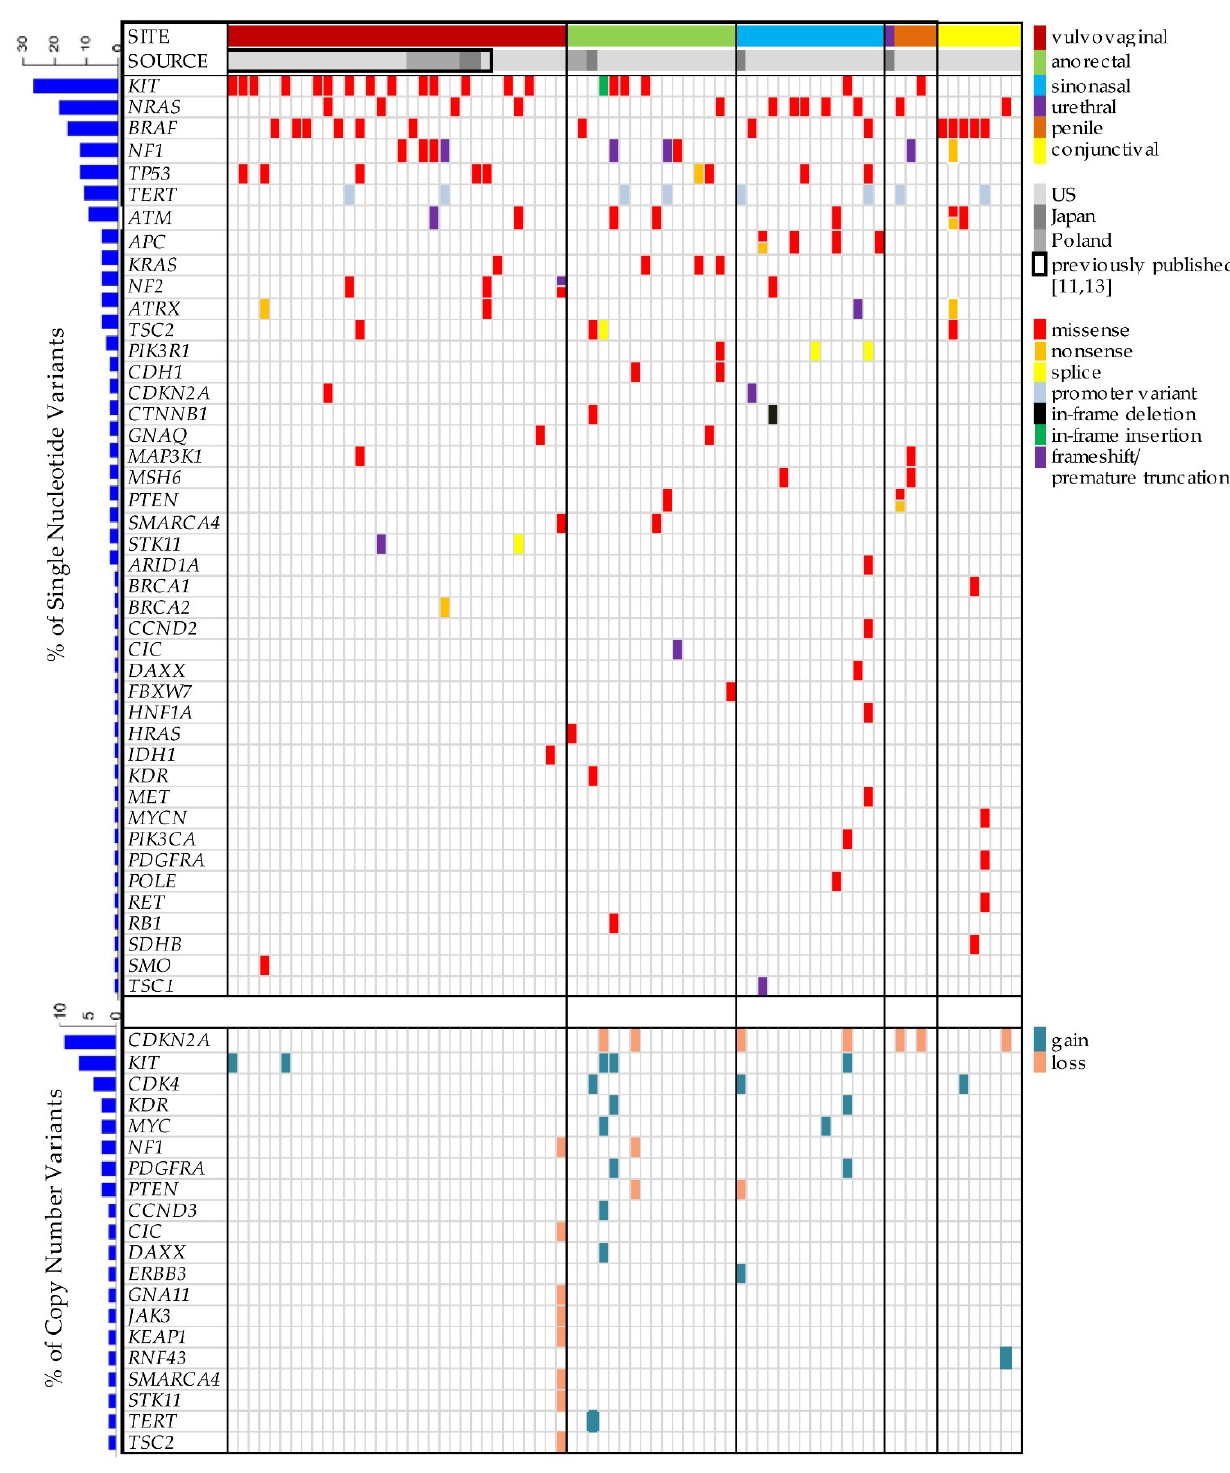
Figure 3. Summary of next-generation sequencing performed on 75 cases. Univariate analyses are performed for the following variables: NRAS , KIT , BRAF , SF3B1 and IGF2R mutation; stage; age; ulceration; mitoses; perineural invasion; lympho- vascular invasion; and adjuvant therapy. Advanced stage (3 or 4, p = 0.018), age older than 65 years ( p = 0.036) and presence of ulceration ( p = 0.028) were significantly correlated with worse OS, respectively (Table S4). Whether the patient had received adjuvant therapy af- fected only PFS but not OS or MSS (Table S4). No significant correlation was observed